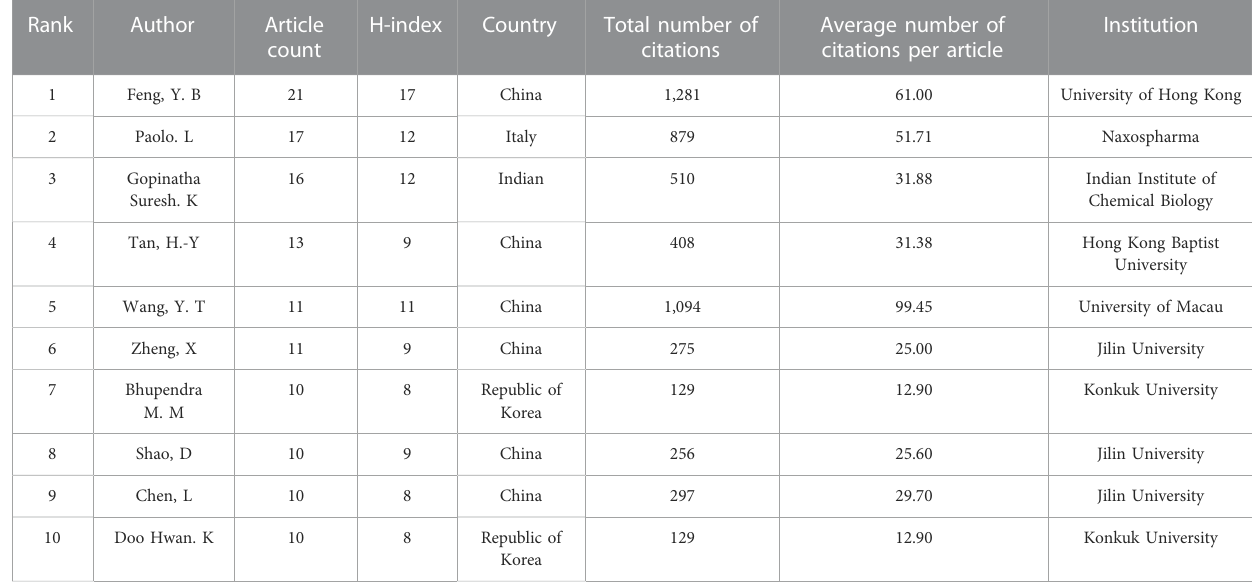
TABLE 3 Top 10 authors that contributed publications on BBR and tumors.